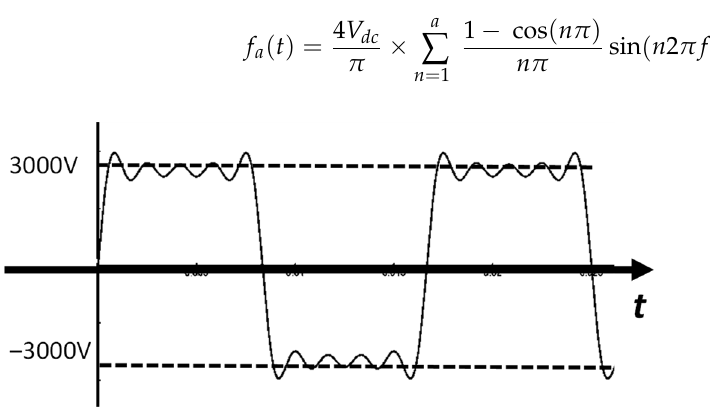
Figure 21. 2-level approximated waveform.